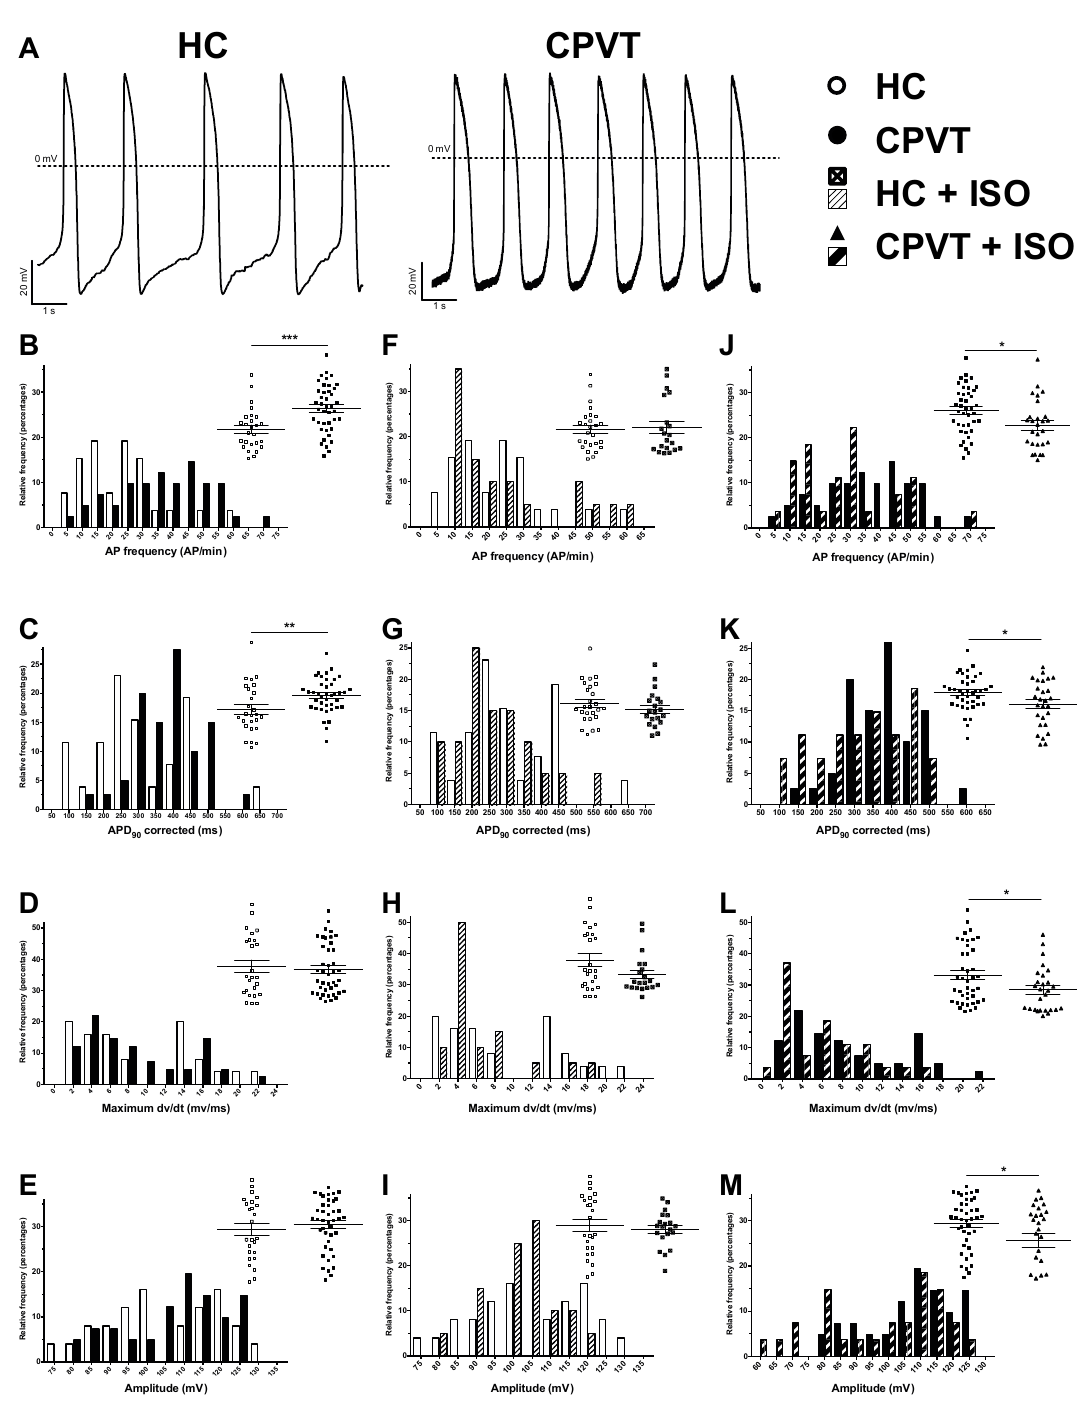
Figure 5. Action potential parameters from spontaneous electrical activity. ( A ) Example of spontaneous action potentials (AP) from HC (left) and CPVT (right) hiPSC-CM recorded using the patch-clamp technique on isolated cardiomyocytes. ( B – M ) AP characteristics are studied and were compared between: HC ( n = 26) and CPVT ( n = 41) ( B – E ), HC ( n = 26) and HC + ISO ( n = 20) ( F – I ) and CPVT ( n = 41) and CPVT + ISO ( n = 29) ( J – M ). For each comparison, the frequency distribution is shown with a scatter plot (with mean ± SEM) in inset to provide an accurate view of population distribution. The parameters studied were the spontaneous AP frequencies ( B , F , J ), the bazett’s corrected APD 90 ( C , G , K ), the maximum depolarization speed (maximum dV/dt) ( D , H , L ) and the AP amplitude ( E , I , M ). * p < 0.05; ** p < 0.01, *** p < 0.001.